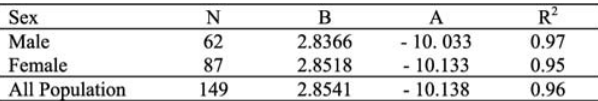
Table 2. Regression parameters from logarithm data by lnTW = A + B lnTL on total weight (dependent) and total length (independent) for males and females of Geophagus brasiliensis in Lajes Reservoir. N – number of individuals; A – intercept; B – slope and R2 – determination